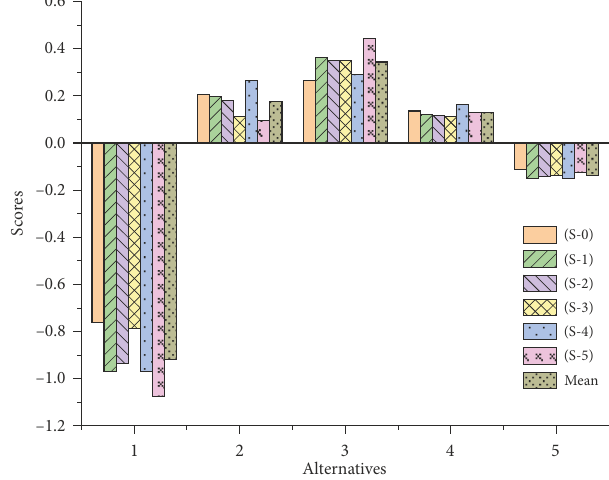
Figure 3. The final scores of alternatives under different experts’ weights